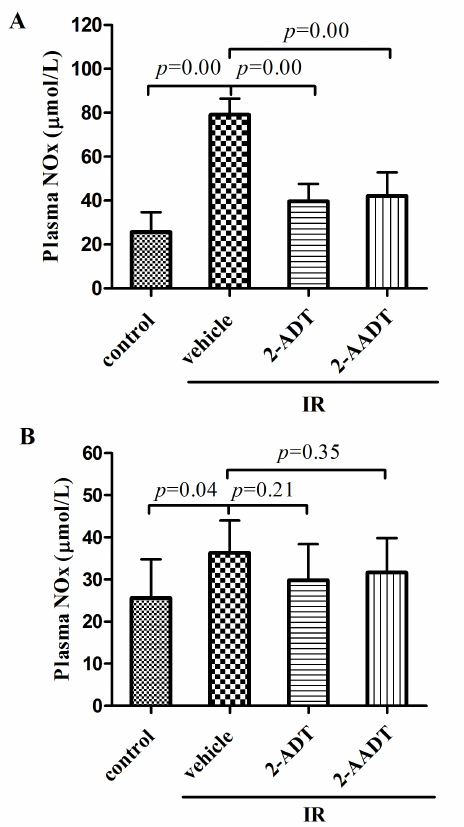
Figure 4. The content of nitrite and nitrate (NOx) in plasma of irradiated and control mice at 6 h and 7 days after 7.5 Gy irradiation. 2-ADT and 2-AADT were administered i.p. 30 min before irradiation. ( A , B ) Plasma NOx content at 6 h and 7 days after irradiation, respectively. the data are presented as the mean ± SD ( n = 12 each). One-way ANOVA was used for statistical comparisons between groups. The p value indicates the difference compared with the IR + vehicle